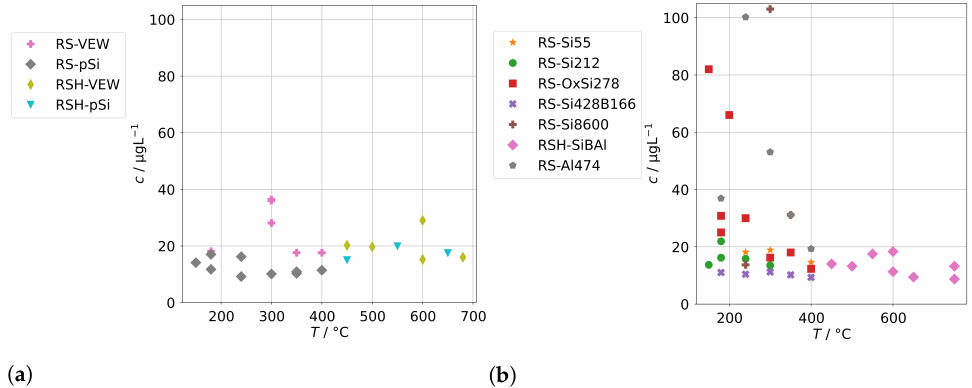
Figure 1. Sodium concentrations in condensates in dependence of operation temperature for the AG- SG: ( a ) Background levels for clean feed-waters; ( b ) Concentrations for spiked feed-water solutions containing sodium.